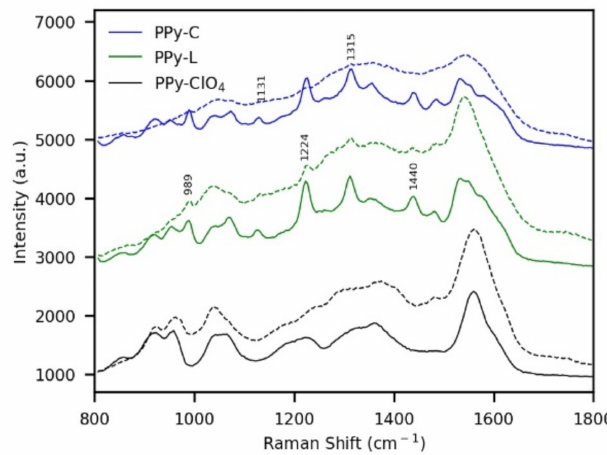
Figure 7. Raman characterization of PPy-ClO 4 , PPy-L and PPy-C before (continuous lines) and after (dashed lines) the photoelectrochemical test under anodic conditions (light chopped chronoamper- ometry at 0.6 V in 0.1 M Na 2 S 2 O 3